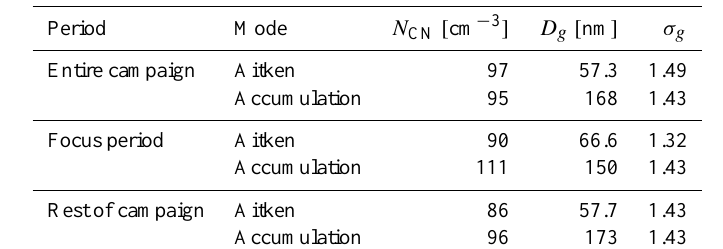
Table 3. Best-fit parameters of bimodal lognormal size distribution functions fitted to the observed median size distributions of aerosol particles (CN) as displayed in Fig. 6 for the entire campaign, for the pristine focus period, and for the rest of the campaign: integral number concentration ( N CN ), count median or geometric mean diameter ( D g ), and geometric standard deviation ( σ g ) for each mode (Aitken and accumulation). The concentration values are normalized to a reference state of 273K and 1000hPa.